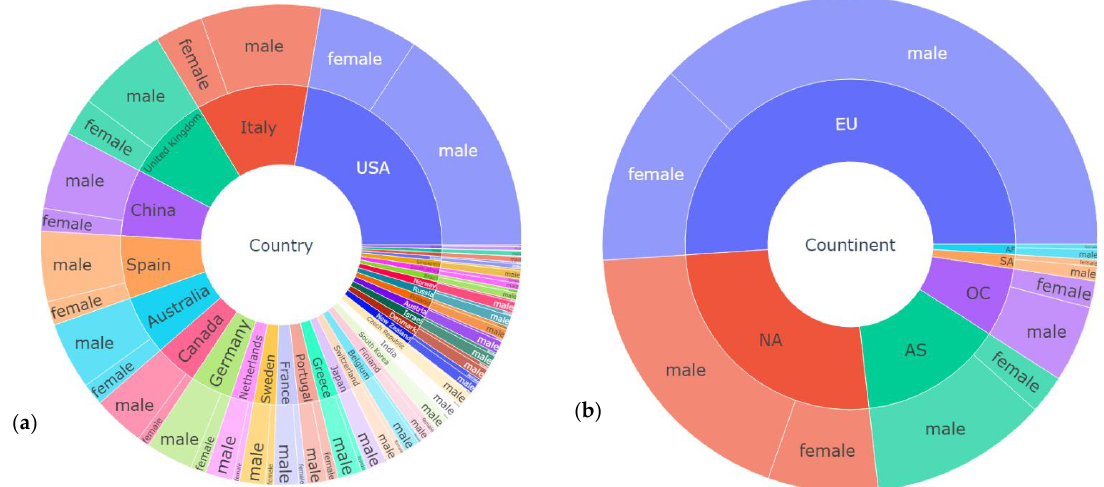
Figure 4. The geographic representation of journal editorial boards by affiliated ( a ) country and ( b ) continent in LS journals.